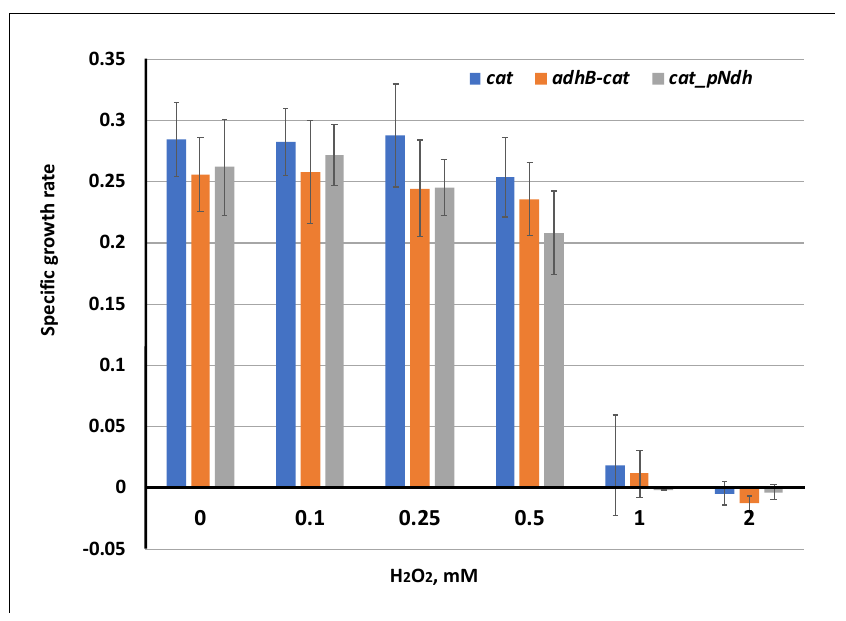
Figure 5. Average specific growth rate (h − 1 ) of the mutant strains with catalase-negative background during a period of 6 h after transferring of cells to fresh growth medium, supplemented with hydrogen peroxide. The differences between the specific growth rates of the strains are not statistically significant at any one of the applied H 2 O 2